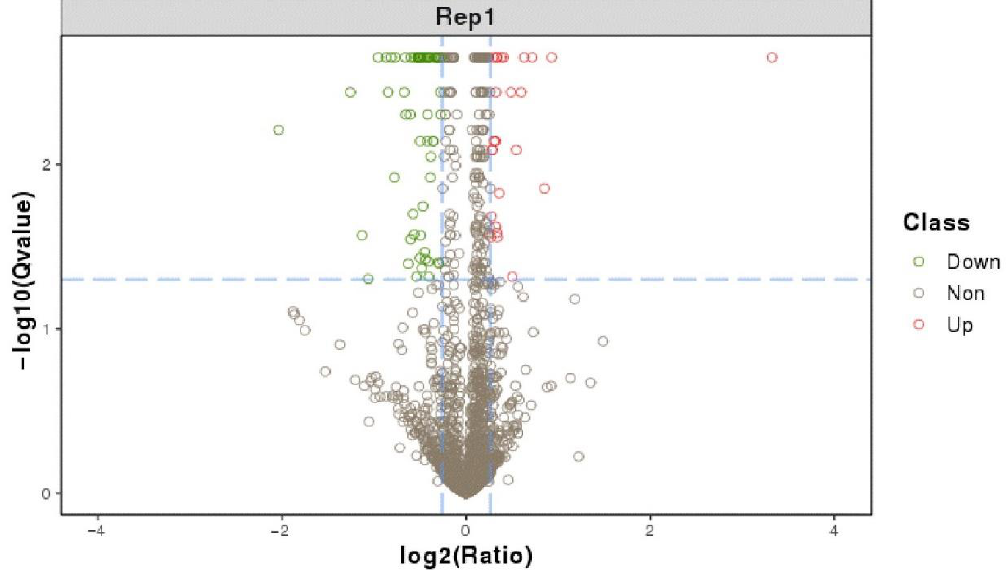
Figure 5. Differentially expressed protein volcano graph. The X-axis is the protein difference multiple (take log2) and the Y-axis is the corresponding − log10 (Q-value).